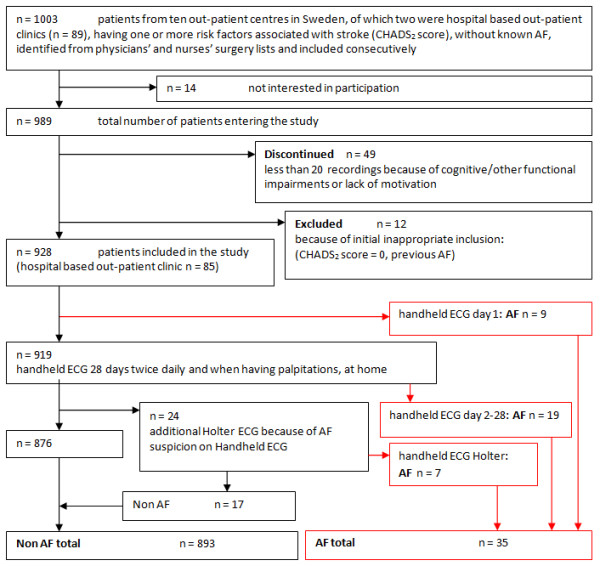
Study flowchart.